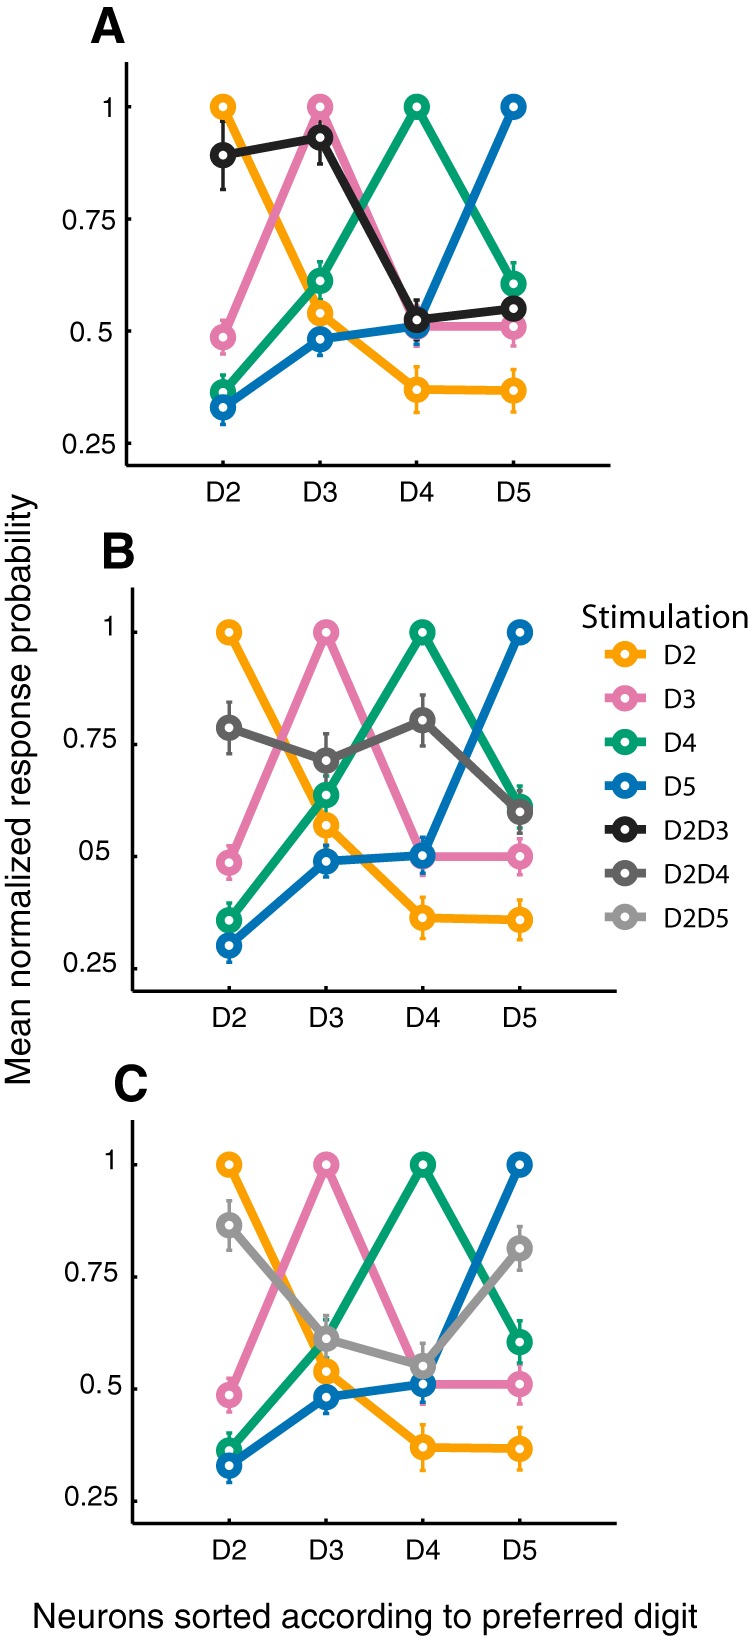
Cortical pattern reconstruction from the population responses. Mean normalized response probability (± standard error) to different stimulation conditions for neuronal populations sorted out according to the unit’s preferred digit, i.e., the digit whose stimulation elicited the highest probability of response. Population patterns for all neurons recorded after single-digit stimulation and D2D3 (A), D2D4 (B), or D2D5 (C) costimulation.